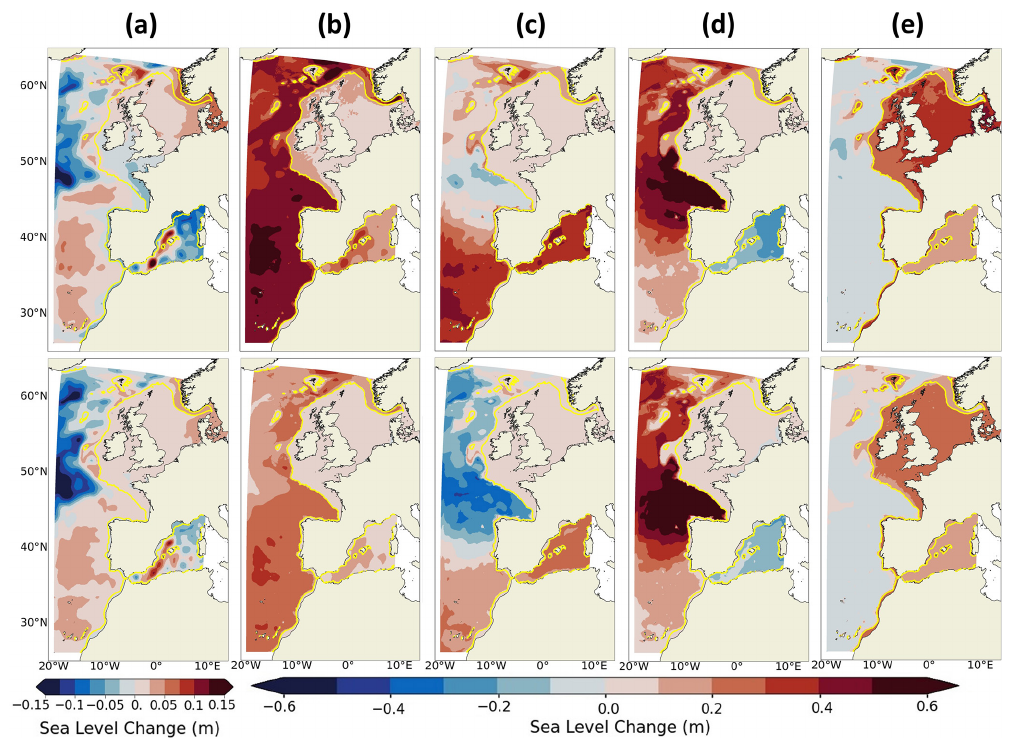
Figure 12. Projected changes (2081–2100 vs. 1986–2005) under the SSP5-8.5 (upper row) and SSP1-2.6 (lower row) scenarios in the IBI- CCS_corr simulation for the (a) DSL, (b) steric, (c) thermosteric, (d) halosteric and (e) manometric SL components. The steric, thermosteric and halosteric SL components have been computed between 0–2000m depth. Note that the DSL mean over the IBI zone is 0. Note that the projected changes of the inverse barometer effect are not incorporated in the projected changes of manometric sea level (e) . Moreover, as the changes are computed 0–2000m, the steric and manometric sea level changes are not equal to the DSL changes here. The shelf break (defined by the 200m isobath) is indicated in